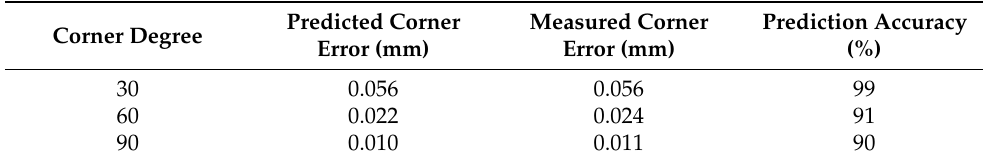
Table 14. Corner error using optimized parameters.